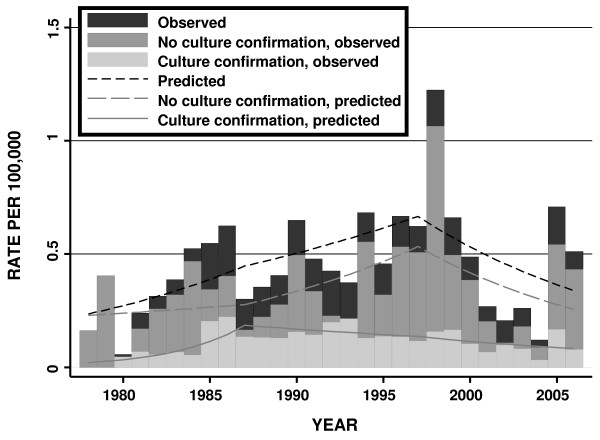
Observed and Model-Predicted Legionellosis Rates by Culture Confirmation in Ontario from 1978 to 2006. Bars represent observed rates of disease (black bars = overall rates; white bars = rates of disease without culture confirmation; gray bars = rates of disease with culture confirmation). Lines represent fitted regression model with spline knots occurring at approximately decade-long intervals. All rates associated with statistically significant decline since 1998.